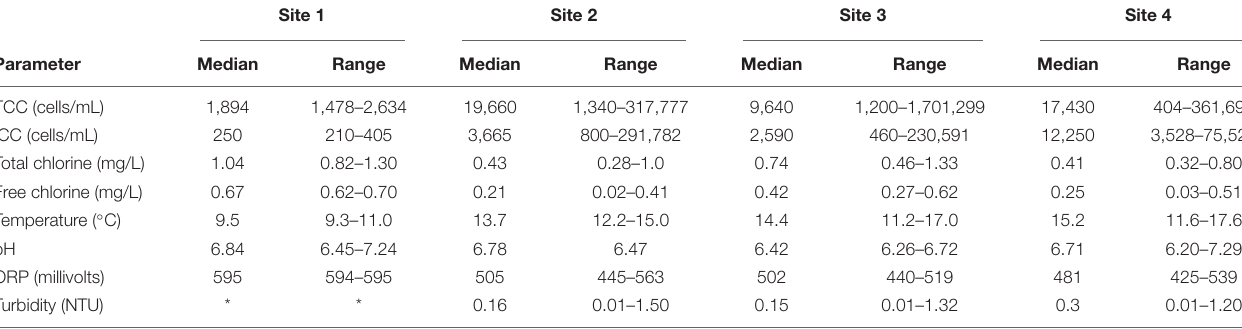
TABLE 3 | Bulk water quality supplying the biofilm monitoring devices at Sites 1, 2, 3, and 4.